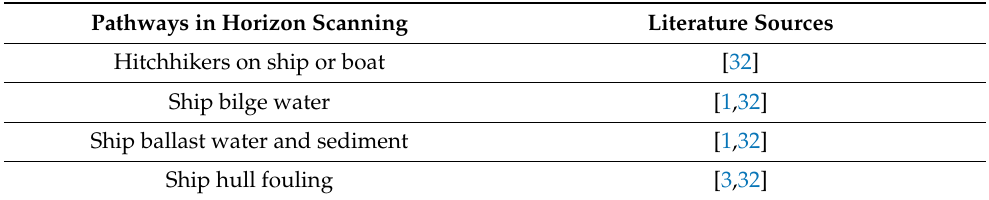
Table 2. Possible habitats of potential IAS to the Baltic Sea.